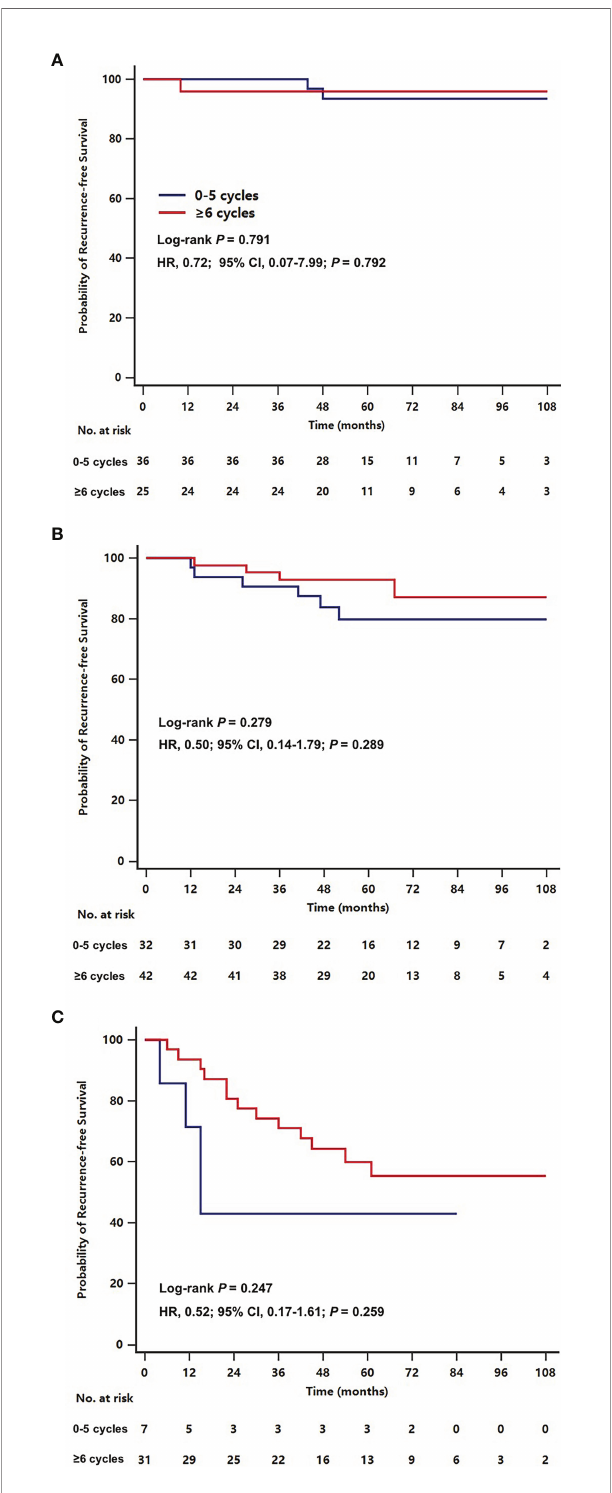
FIGURE 3 | Kaplan-Meier plots for recurrence-free survival by receiving ≥ 6 or 0-5 cycles of chemotherapy in older women with stage I (A) , stage II (B) , stage III (C) triple-negative breast